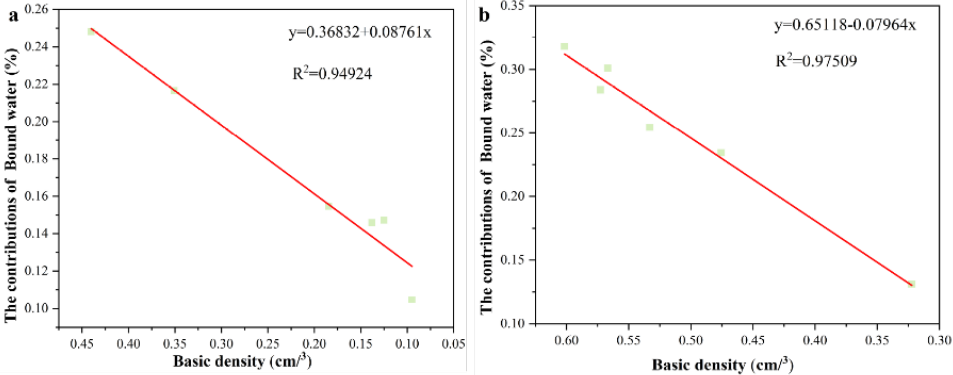
Figure 11. The relationship between the bound water contribution ratio and the basic density (( a ), waterlogged archaeological wood; ( b ), modern wood). Note: the values in the figure are the average values of three experimental tests and calculations.